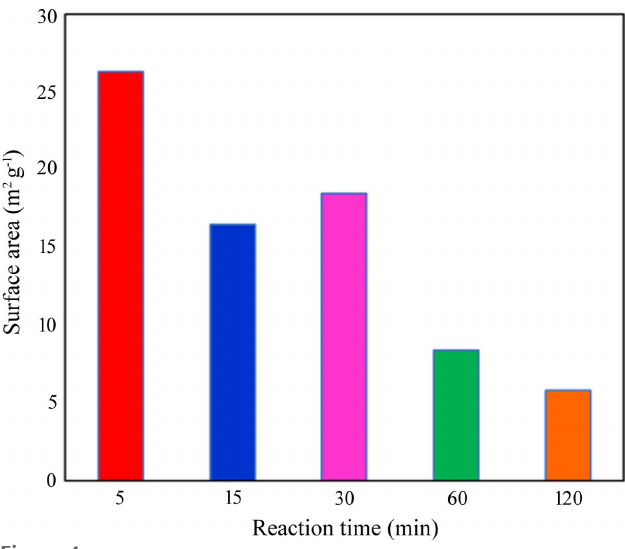
Figure 4 Specific surface areas of Ag-DNF samples with various synthesis times.